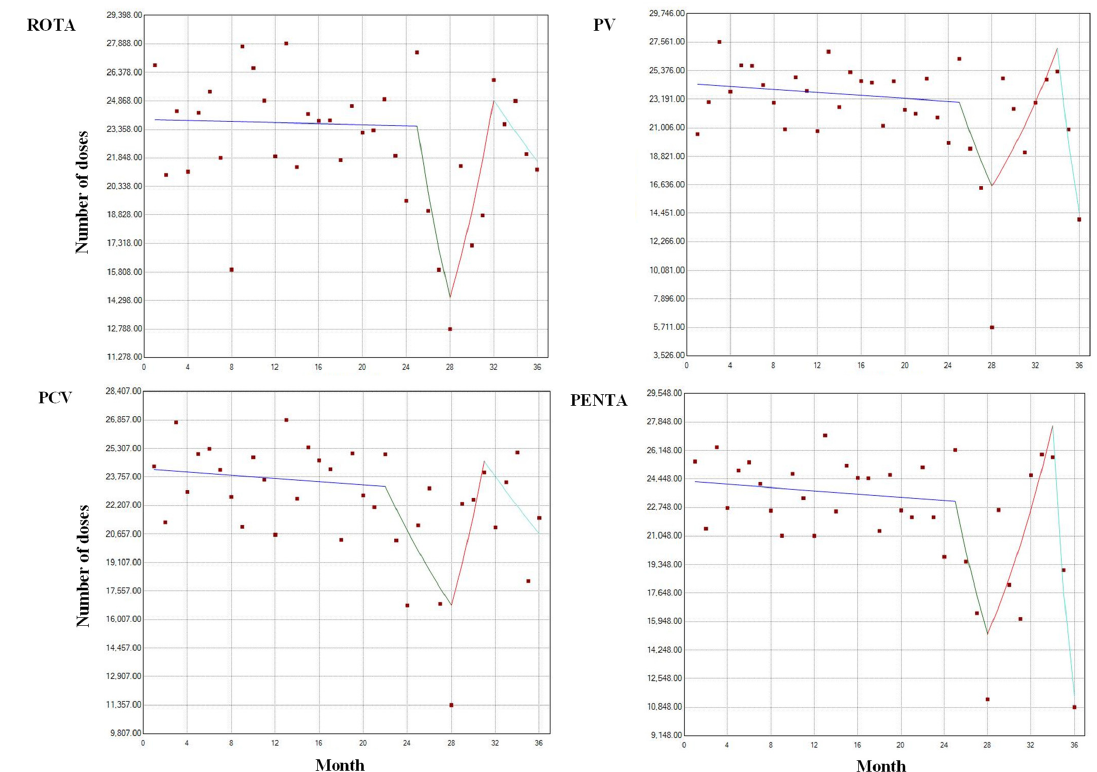
Figure 4. Yearly Joinpoint analysis of immunizations administered for infants in Ecuador. The four graphs show the number of the last doses administered of rotavirus, poliovirus, pneumococcal, and